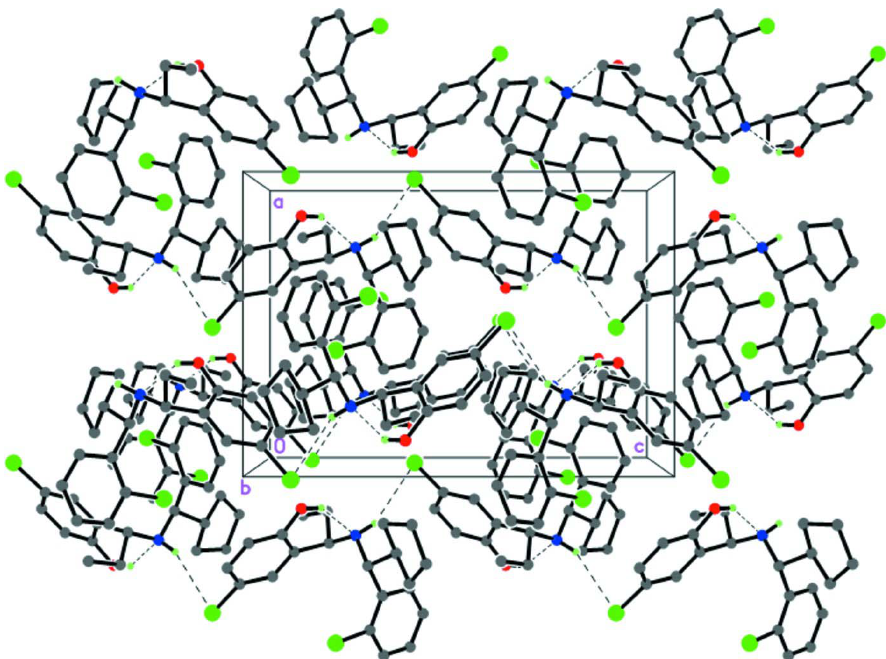
Figure 2 A packing diagram of (I), view down the b axis, showing the formation of helical chains through O1—H1A···N1 and N1 —H1···Cl2 hydrogen bonds (dashed lines). H atoms not involved in hydrogen bonds have been omitted. 4-Chloro-2-((1 R )-1-{[( R )-(2-